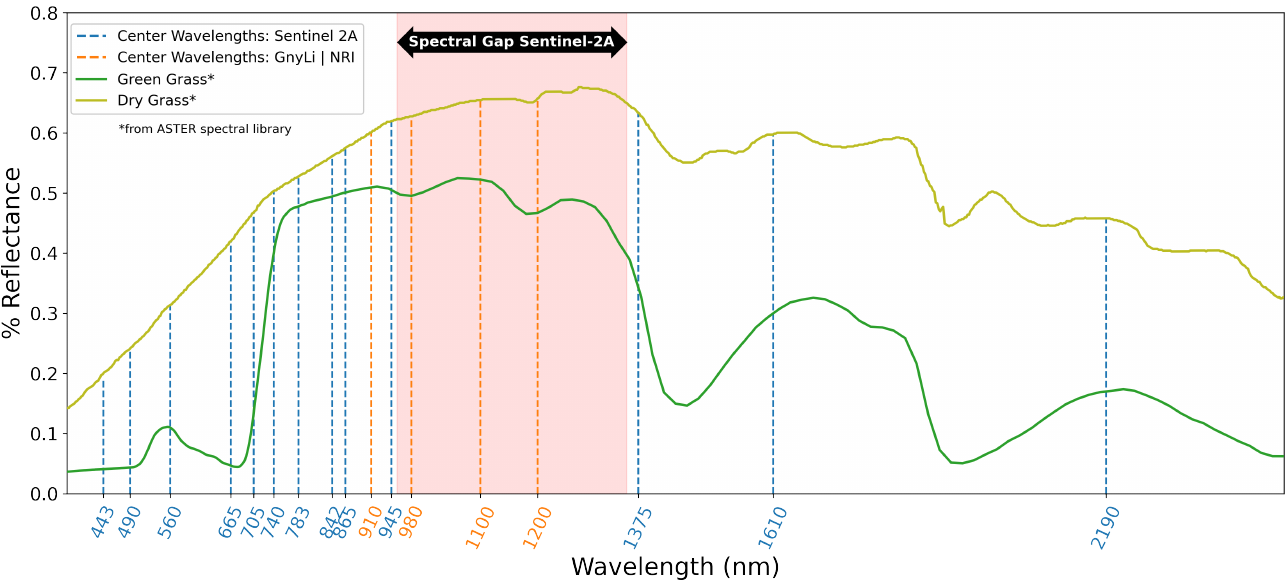
Figure 1. Typical reflectance spectra for green and dry grass plotted from the ASTER spectral library [31], the center wavelengths of Sentinel-2A [32] (dashed vertical blue lines), and the applied center wavelengths of the VNIR/SWIR multi-camera system for the GnyLi and the NRI (dashed vertical orange